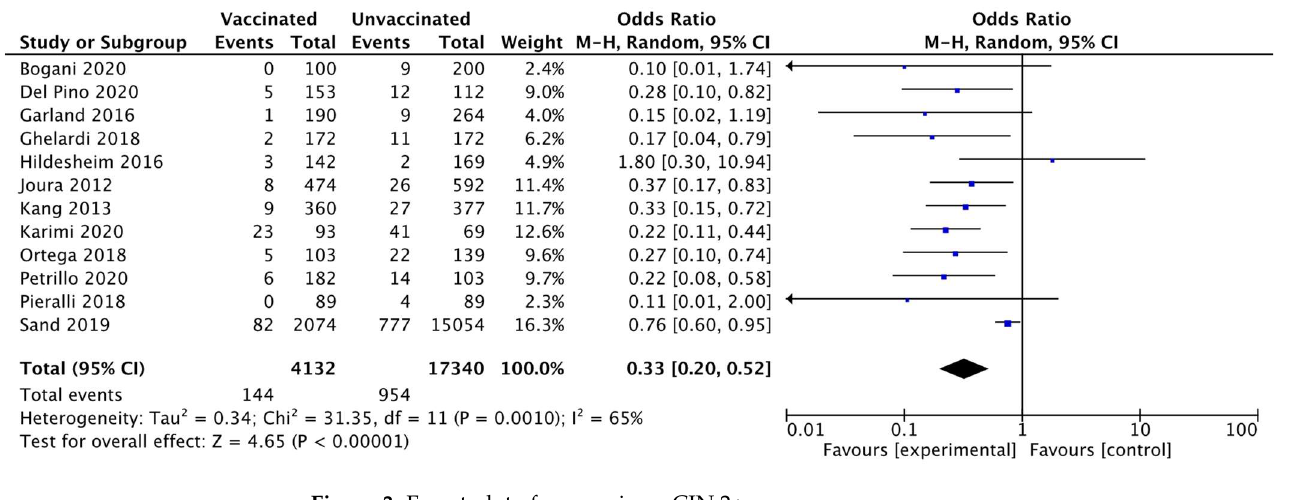
Figure 3. Forest plot of comparison: CIN 2+ recurrence.